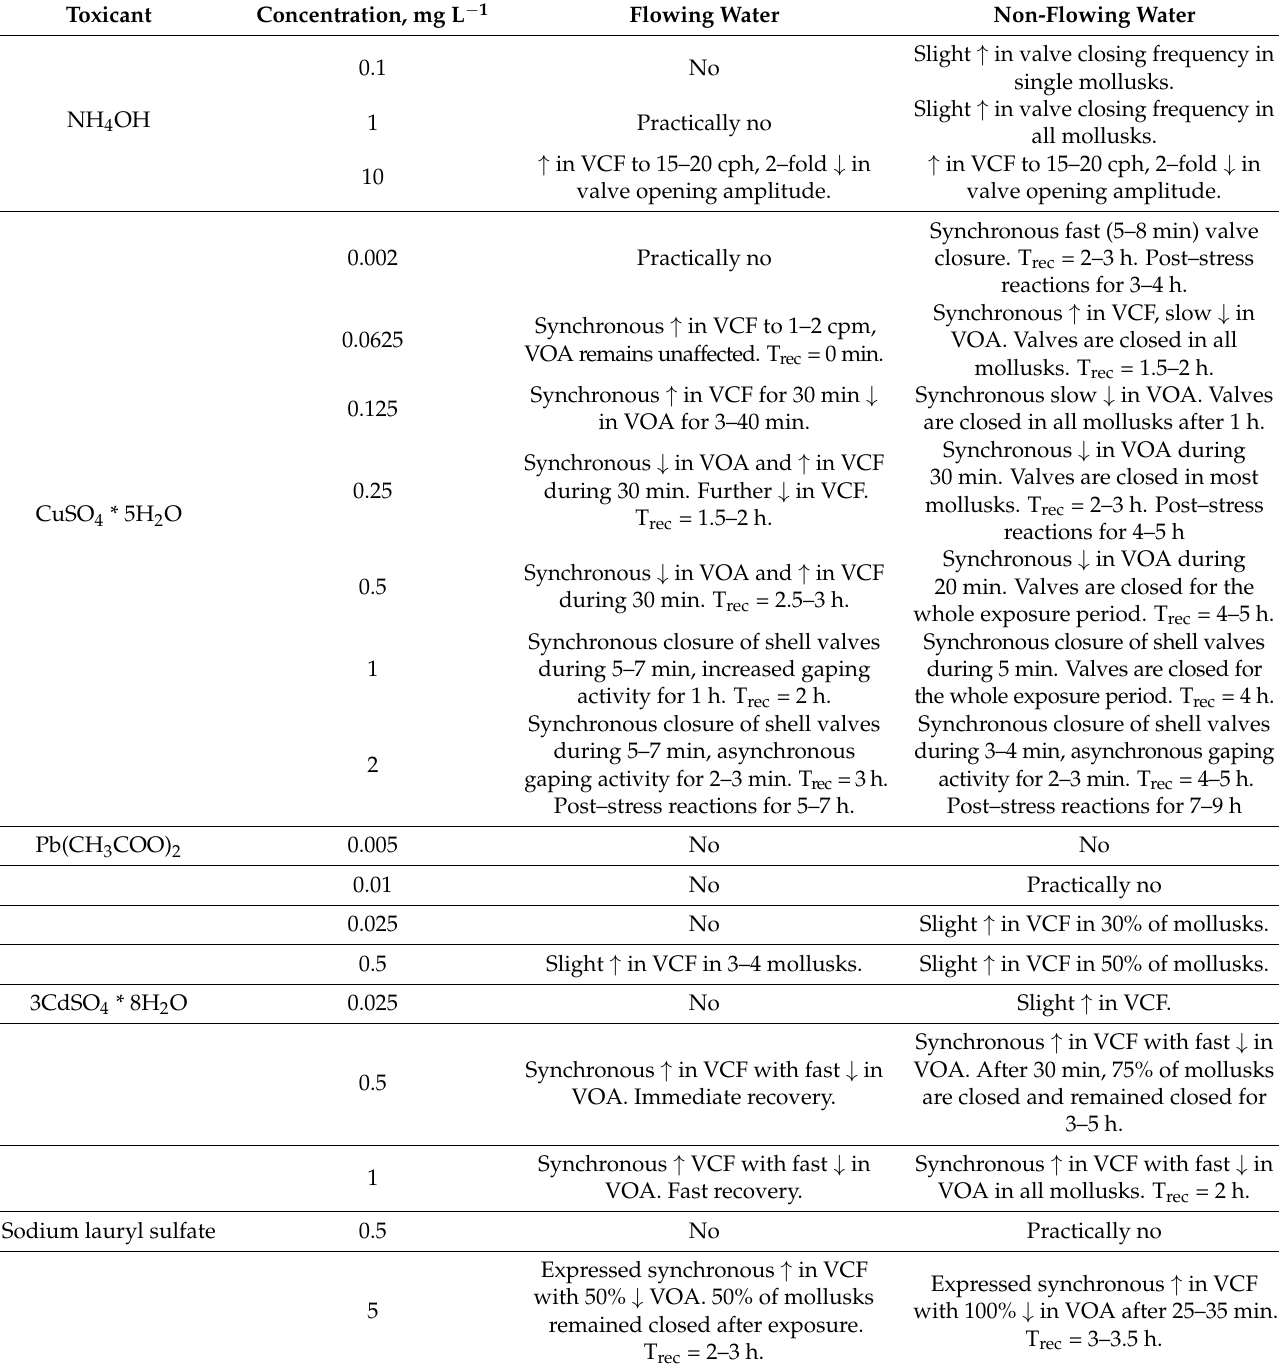
Table 1. Responses of Painter’s mussels Unio pictorum to different toxicants (adopted from